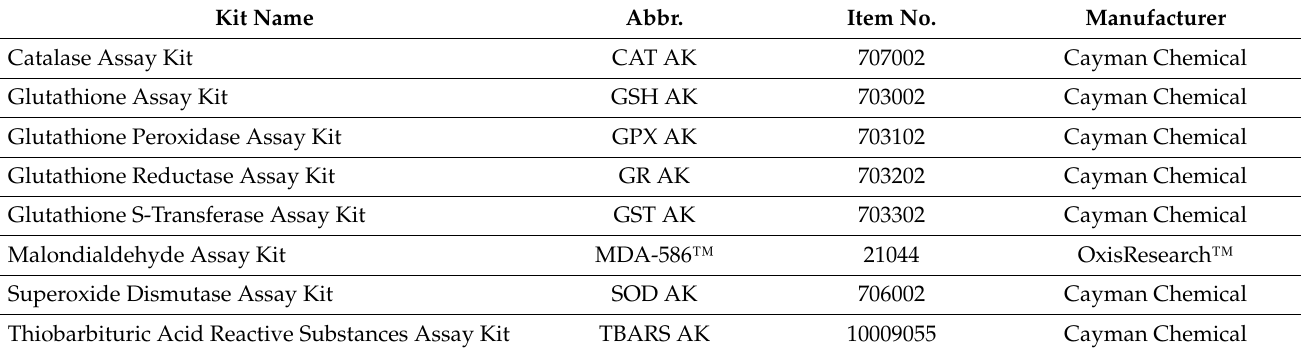
Table 1. ELISA kits used for measurements of oxidative stress